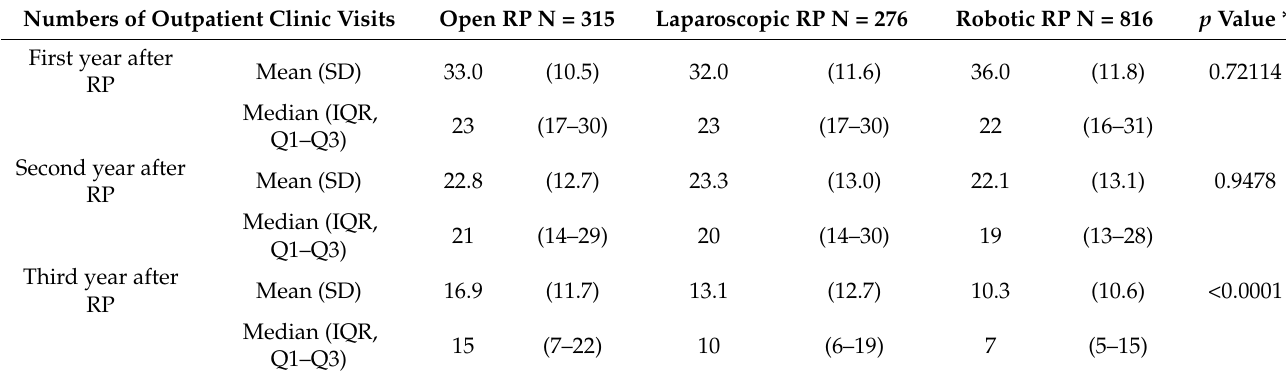
Table 2. Generalized linear mixed model of numbers of urology outpatient clinic visits stratified by open, laparoscopic, and robotic